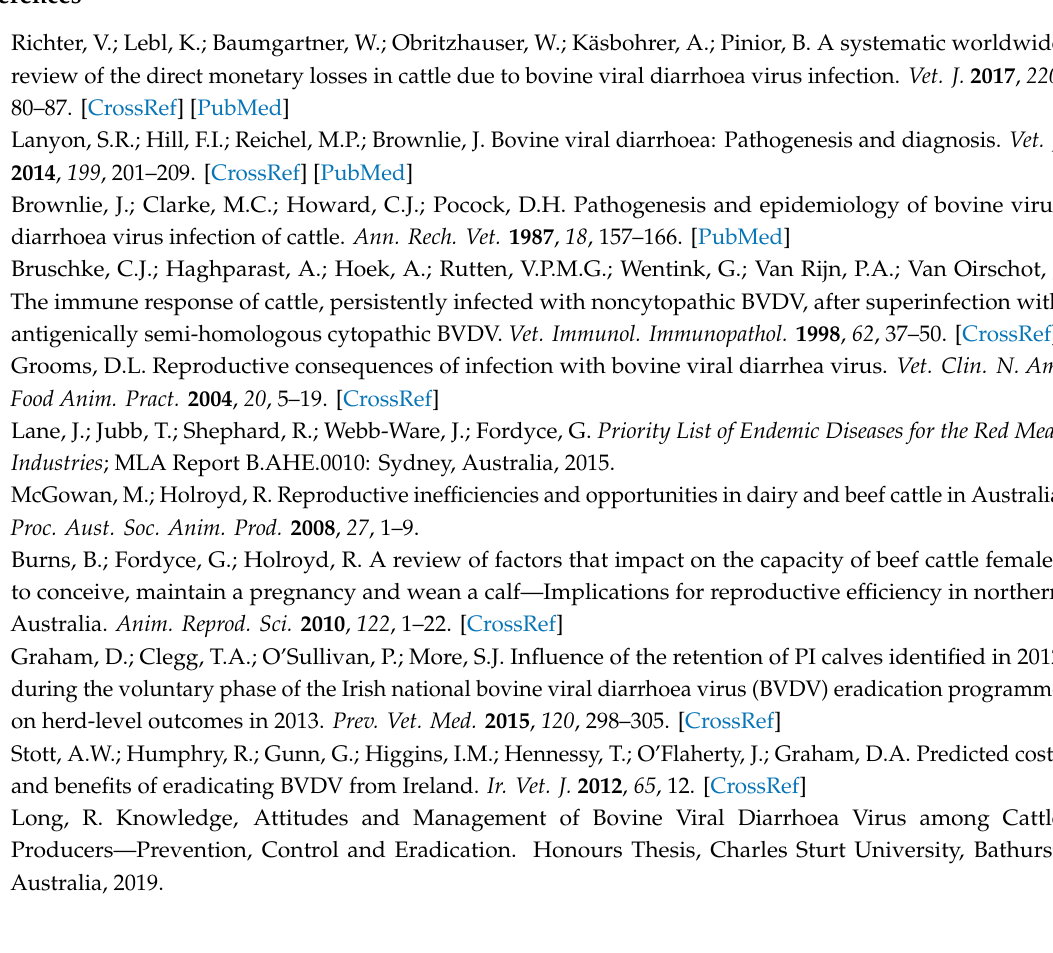
Figure S1: Count of veterinarians working on beef or dairy properties and the number of properties seen each week in a survey of veterinarians’ knowledge, attitudes and practices associated with bovine viral diarrhoea virus management on farms in the temperate zone of south-east Australia in 2019. Figure S2: Counts of veterinarians in each age group in a survey of the knowledge, attitudes and practices associated with bovine viral diarrhoea virus management on farms in the temperate zone of south-east Australia in 2019. Figure S3: Barplot of the number of tests reported as being used by veterinarians to detect the presence of BVDV, in a survey of veterinarians’ knowledge, attitudes and practices associated with BVDV management on properties in the temperate climate zone of south-east Australia in 2019. VNT = Virus neutralisation test, AGID = Agar Gel Immunodi ff usion Assay, VI = viral isolation, IH = immunohistochemistry, PCR = Polymerase chain reaction, ELISA = enzyme-linked immunosorbent assay. Figure S4: Number of veterinarians reporting deliberate exposure to di ff erent stock types, in a survey of veterinarians’ knowledge, attitudes and practices associated with BVDV management on farms in the temperate zone of south-east Australia in 2019. Figure S5: Boxplots of the estimated within herd prevalence of the grouped diseases, prevalence of the grouped diseased in BVDV persistently infected cattle (PI), and the proportion of producers testing for the grouped diseases on beef (left) and dairy (right) properties, in a survey of veterinarians’ knowledge, attitudes and practices associated with BVDV management on farms in the temperate zone of south-east Australia in 2019. Other = lice and infectious bovine